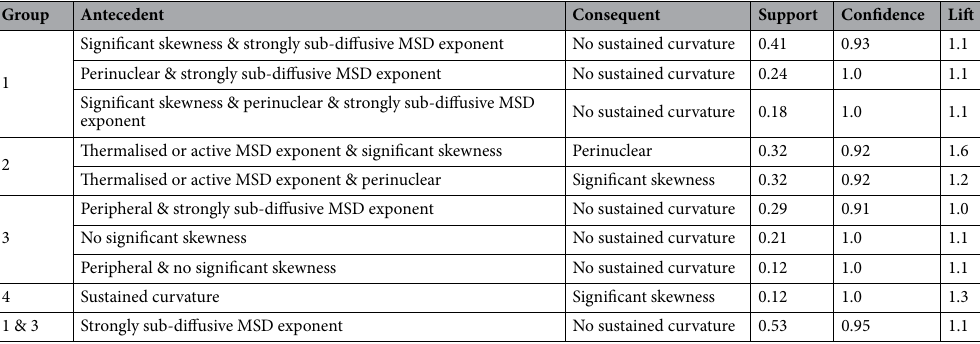
Table 1. Association rules found using itemset mining. Support, confidence and lift are given to 2 significant figures. Support gives the proportion of tubules in which a given itemset occurs and confidence is a measure of how often a rule applies within the population of tubules for which the antecedent is true. Lift is a measure of how much more likely the consequent is to occur along with the antecedent than on its own, considering all tubules (see “Methods”). Rules which are related are grouped together. The last row relates to both groups 1 and